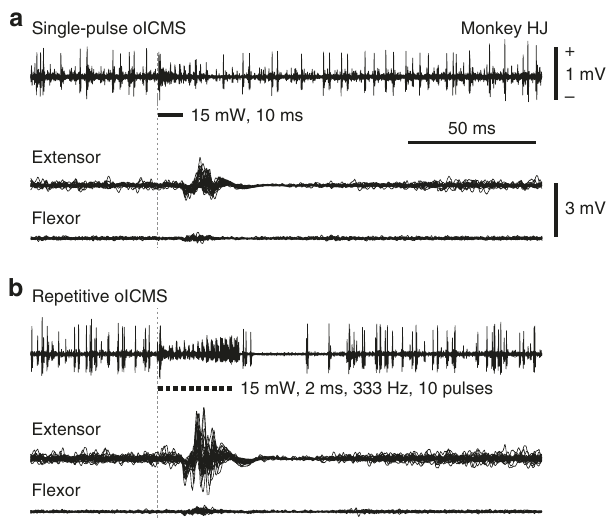
Fig. 3 Simultaneously recorded M1 and muscle activity evoked by oICMS. a , b M1 activity (top trace) and electromyograms (EMG; bottom two traces) induced by single-pulse ( a , 15 mW strength corresponding to 1910 mW/mm 2 , 10 ms pulse duration) and repetitive ( b , 15 mW, 2 ms, 333 Hz, 10 pulses) oICMS. M1 neuronal activity was recorded probably from neurons in layer 5. EMG was recorded from the extensor carpi radialis longus (Extensor) and fl exor carpi radialis (Flexor) muscles. Vertical dashed lines and thick black horizontal lines indicate the beginning and duration of light illumination, respectively. Calibration in a is applicable to b